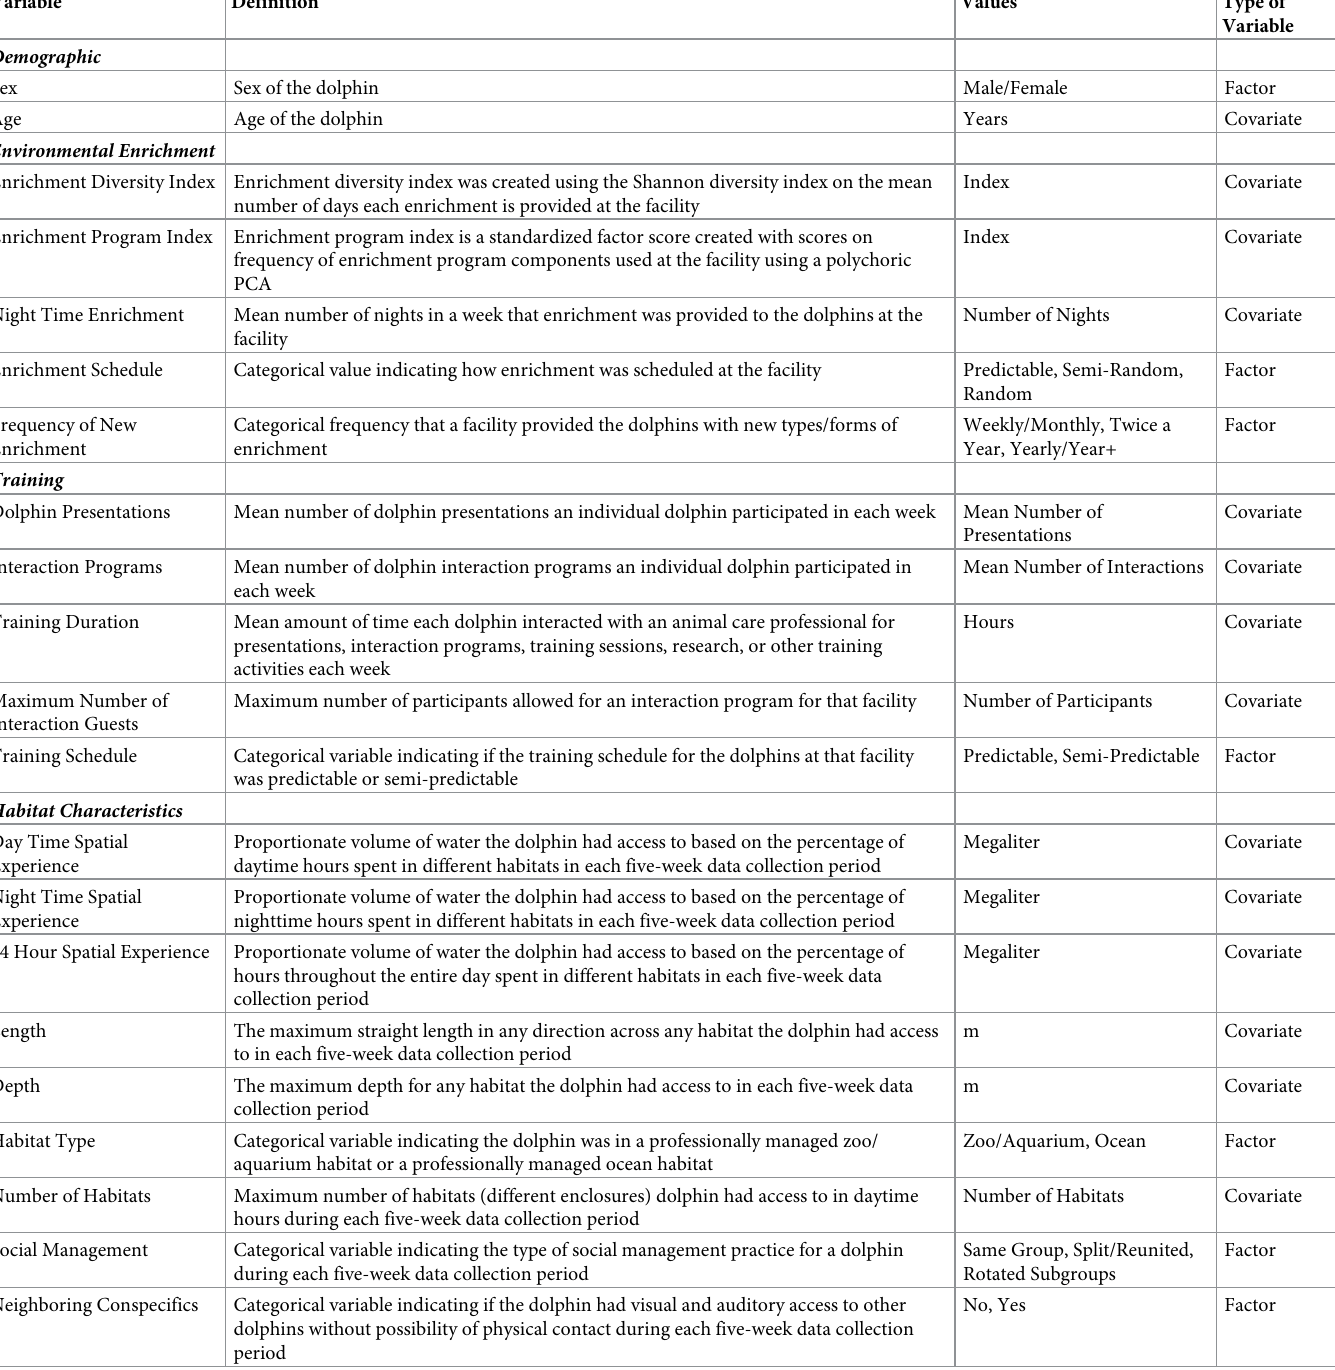
Table 2. Independent variables included in the